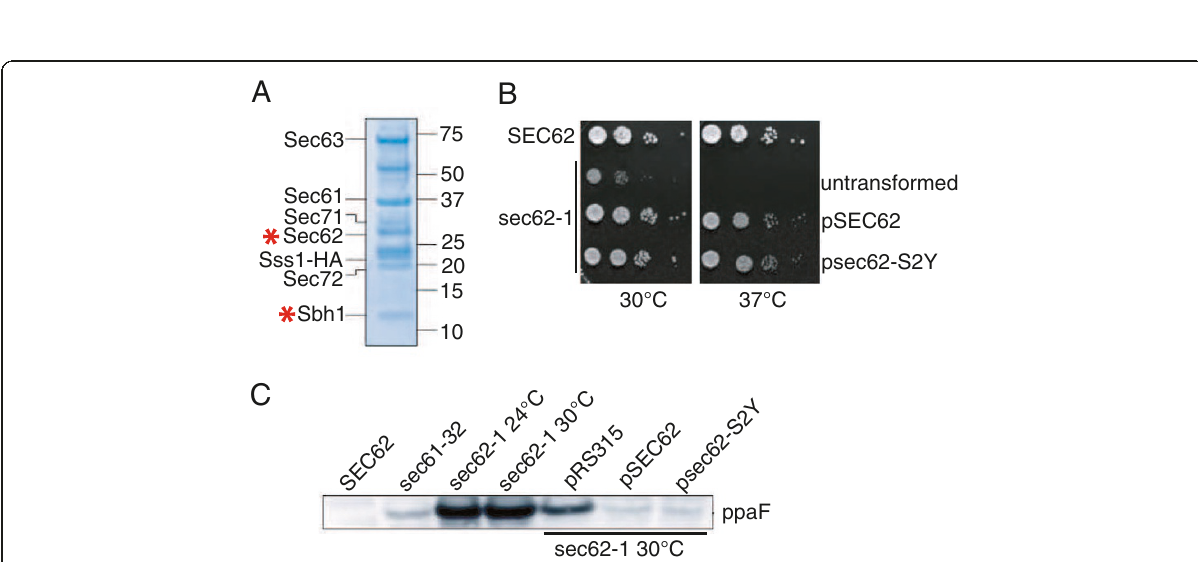
Figure 6 Sec62p and Sbh1p are N-acetylated. ( A ) Sec complexes and ribosome-free Sec61 complexes were purified from an SSS1-HA strain by affinity chromatography as described in Methods. Individual bands were excised, trypsin-digested and analyzed by mass spectrometry. N- acetylated proteins are indicated by red asterisks. ( B ) Mutant sec62-1 cells were transformed with a plasmid expressing wildtype SEC62 or N- acetylation acceptor site mutant sec62-S2Y . SEC62 wildtype cells and untransformed and transformed sec62-1 cells were diluted and growth on solid media monitored at the indicated temperatures. ( C ) SEC62 wildtype or the indicated mutant cells without or with the indicated plasmids were grown to early exponential phase, cells lysed, proteins separated by SDS-PAGE and prepro-alpha factor (ppaF) detected by